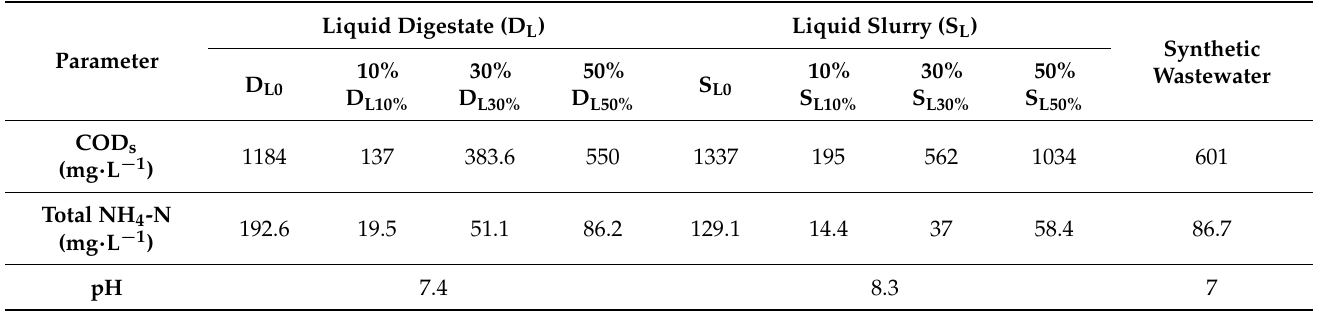
Table 3. Initial characteristics of liquid digestate and slurry after different